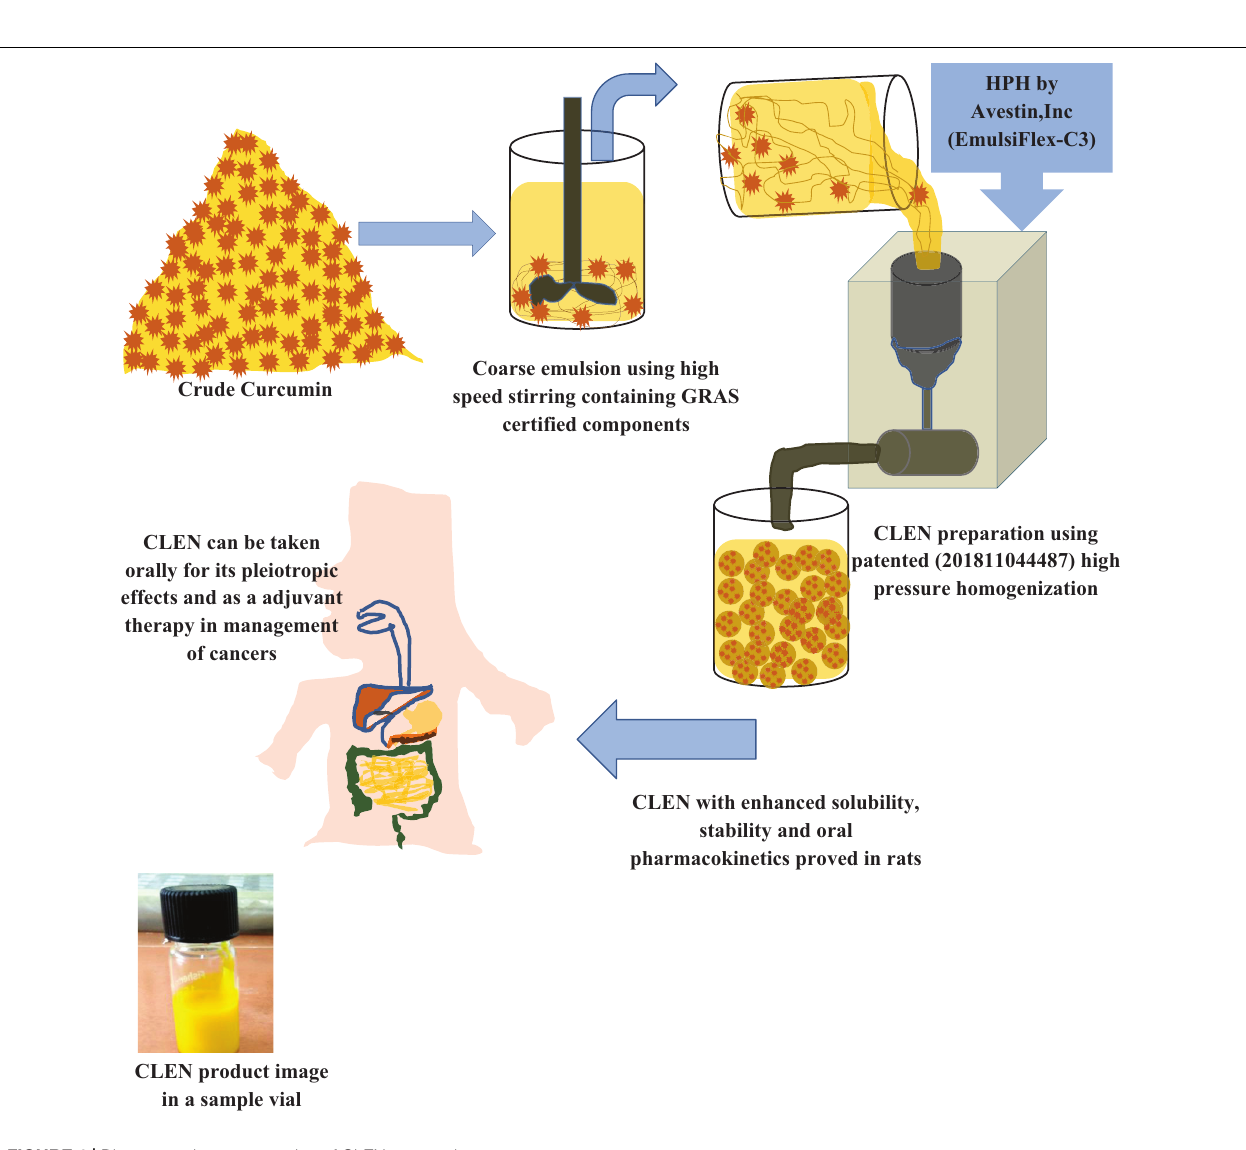
FIGURE 1 | Diagrammatic representation of CLEN